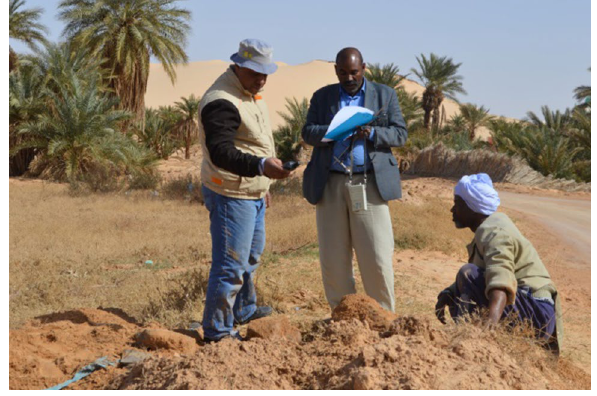
Fig. 5 January 16, 2018, investigations of the seguias of the foggara of Boukhzer. (photo. Authors